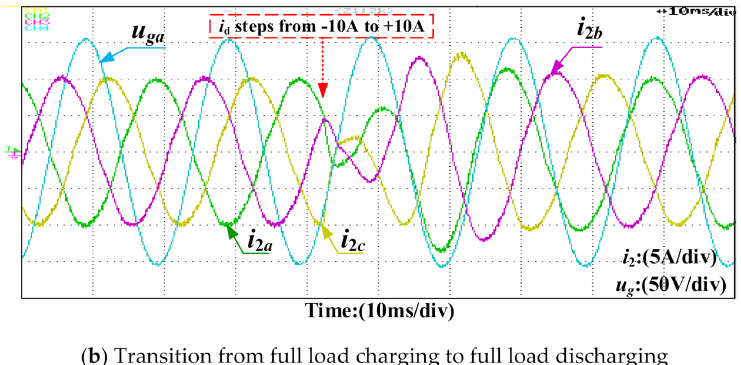
Figure 17. Transient response testing waveforms of the